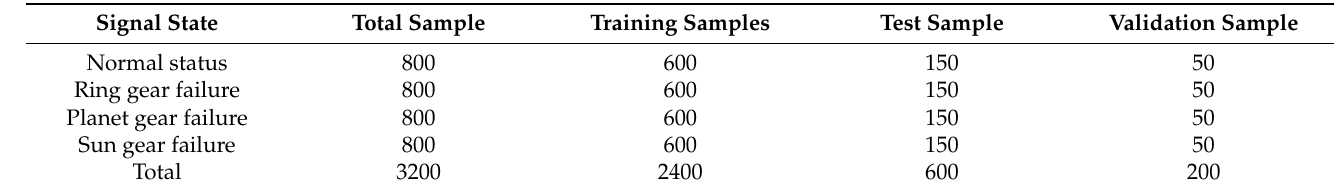
Figure 7. Schematic diagram of wavelet transform of original signal under four fault states: ( a ) normal status; ( b ) ring gear; ( c ) planet gear; and ( d ) sun gear. Table 2. Four kinds of preset fault original signal time–frequency graph data set.